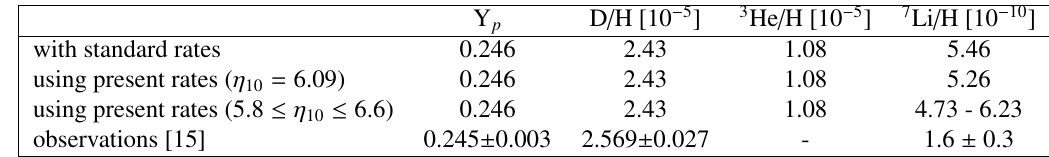
Table 1. Results of the BBN network calculation for the relevant main observables. Present rates refers only to the two rates evaluated in the present work. All the other network rates are adopted as described in [4].